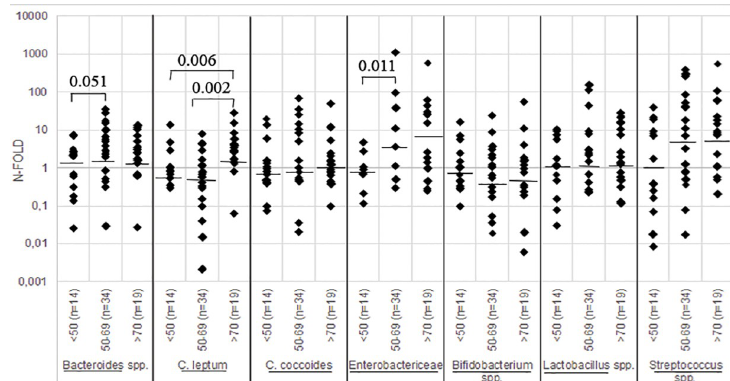
Fig 1. Age-dependent changes in gut bacterial populations in autopsy fecal samples. Age-dependent changes in relative amounts ( i . e . n-fold differences) of the measured bacteria ( Bacteroides spp., Clostridium ( C . ) leptum group, C . coccoides group, Enterobactericeae , Bifidobacterium spp., Lactobacillus spp., Streptococcus spp.). Individual values are presented as boxes, median values as horizontal lines. As a reference value for fecal ΔΔ Cq calculation, the mean Cq value from the < 50 age group was used. Comparisons were calculated first over the groups with the Kruskall-Wallis test and then pairwise with the non-parametric Mann-Whitney U